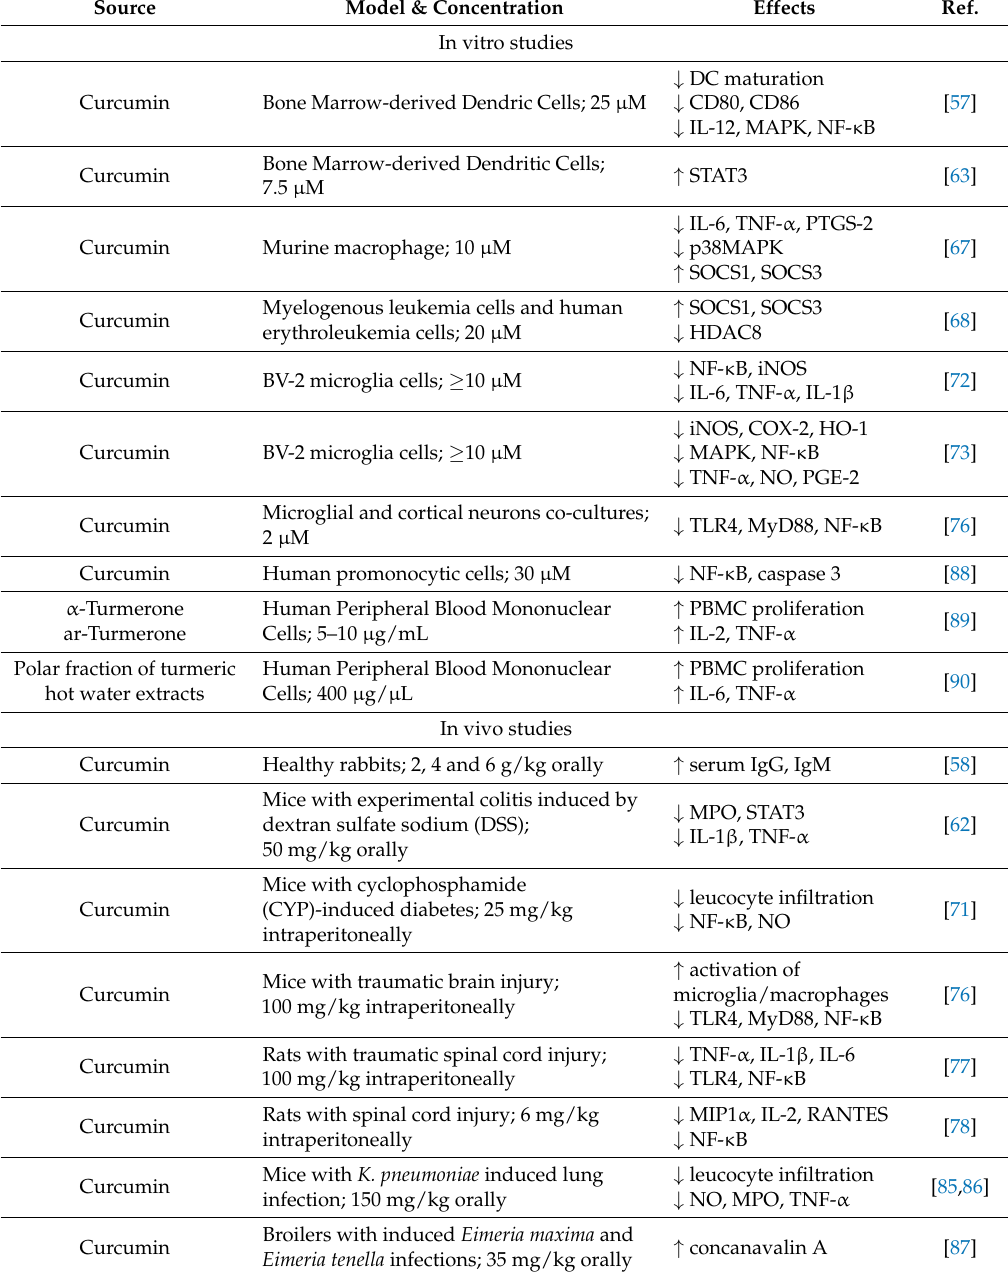
Table 2. Main significant immunomodulatory and antinflammatory effects of curcumin in different in vitro and in vivo